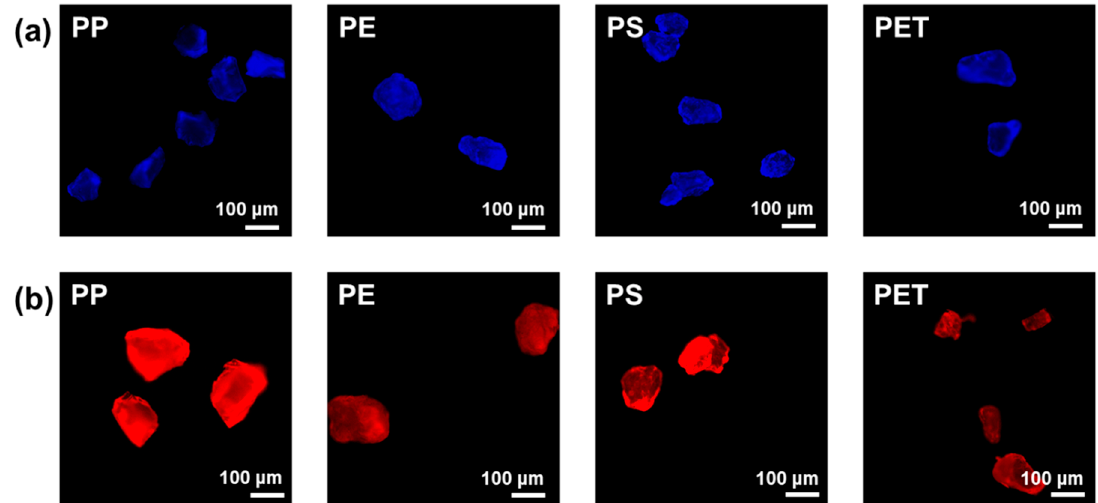
Figure 3. Fluorescence photographs of MPs with different compositions stained with S-FN ( a ) and Nile red ( b ). Staining conditions: surfactant = Tween 20, dye/surfactant = 1 g/L, dye/MP = 2.5 wt%, MP/aqueous solution = 1 g/L, staining time = 60 min, staining temperature = 80 °C.